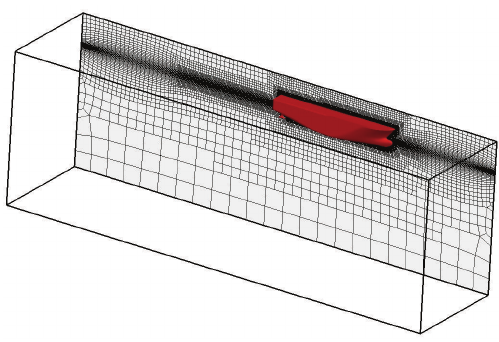
Figure 16: Computational grid of the investigated vessel.